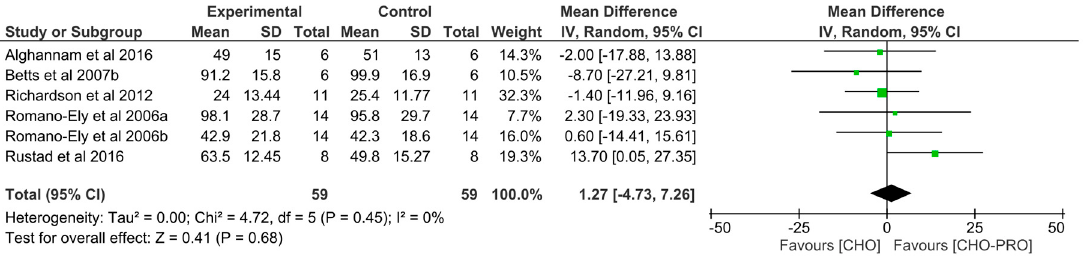
Figure 8. Effect of isocaloric supplementation of CHO-PRO vs. CHO on TTE performance. CI: confidence interval; MD: mean difference.